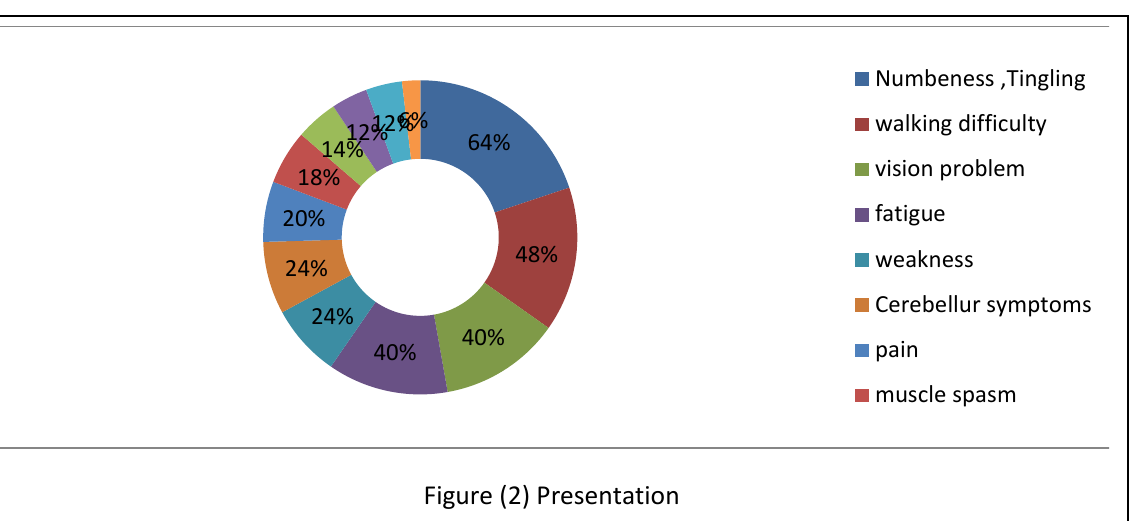
Figure (2) Presentation